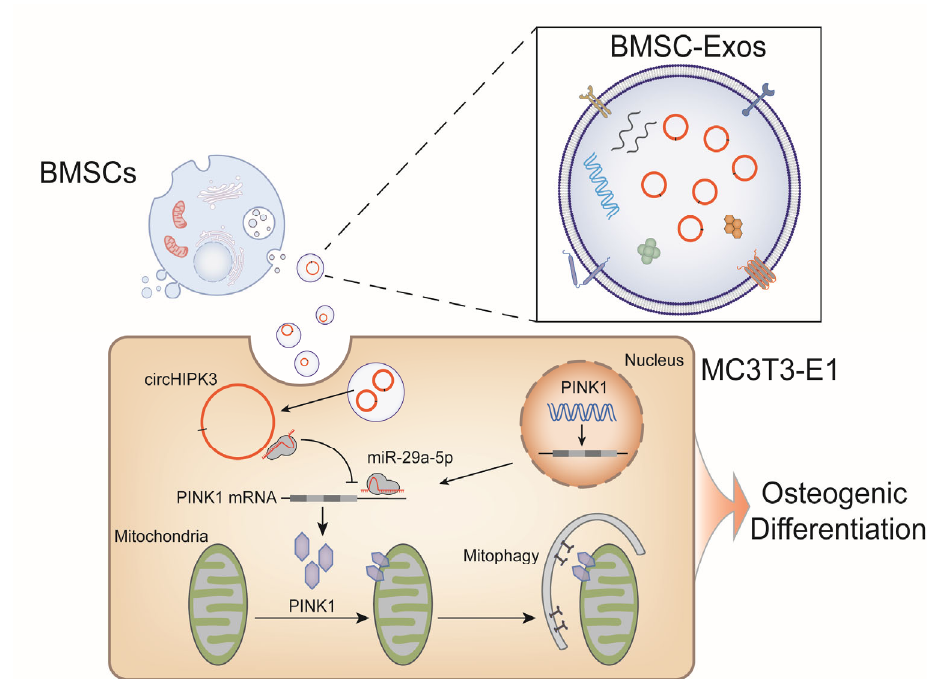
Figure 7. CircHIPK3 is enriched in BMSC ‐ Exos and promotes osteogenic differentiation of MC3T3 ‐ E1 cells by regulating mitophagy through miR ‐ 29a ‐ 5p/PINK1 axis.